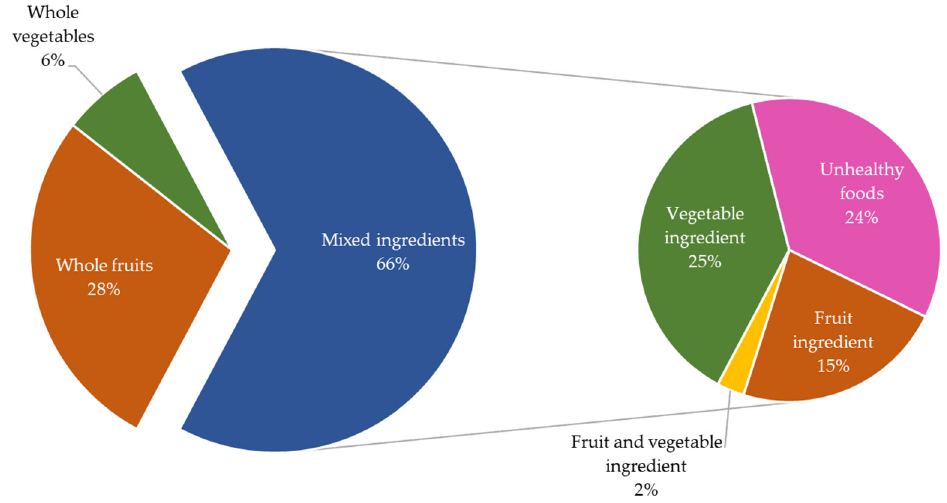
Figure 2. Ingredients within healthy snacks nominated by children (pre-program).